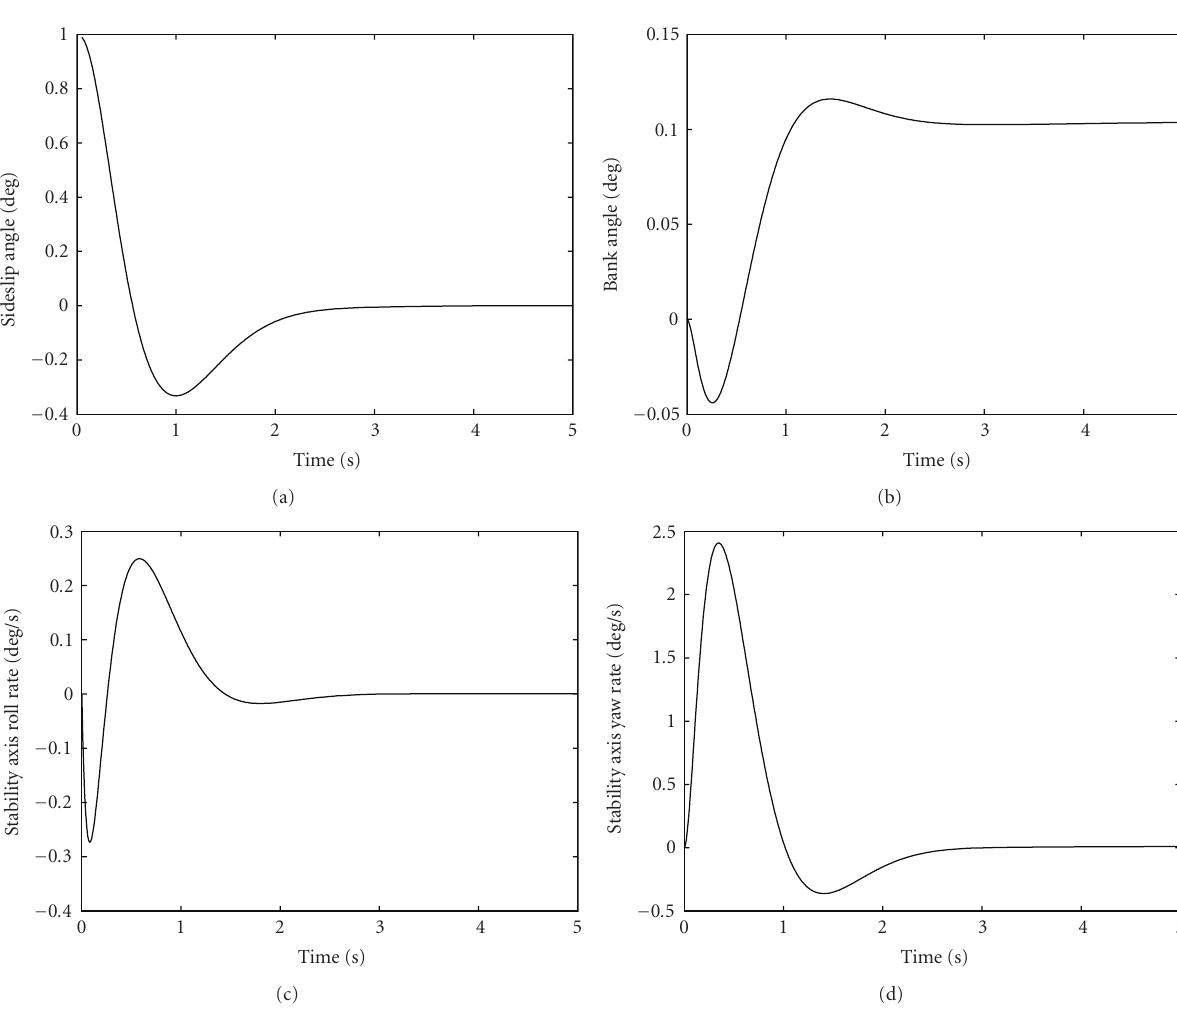
Figure 2: Linear time responses to a 1deg initial